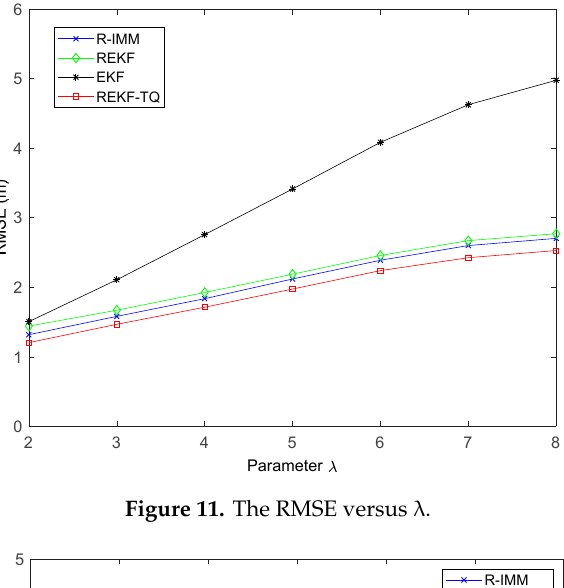
Figure 10. The RMSE versus the number of beacon nodes.